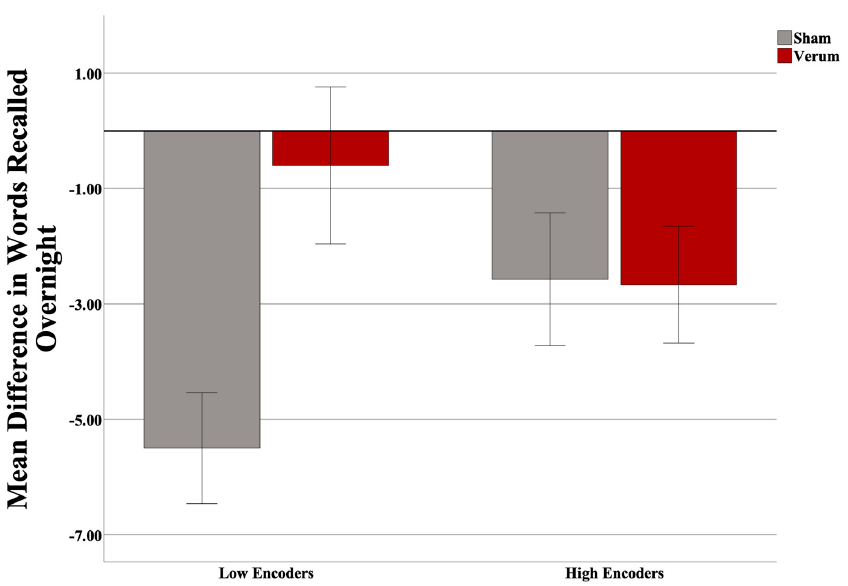
Figure 4. Interaction of encoding strength with stimulation condition. In low encoders, verum tACS led to more words being recalled than sham ( p = 0.0066). Error bars = +/ − 1 SEM.